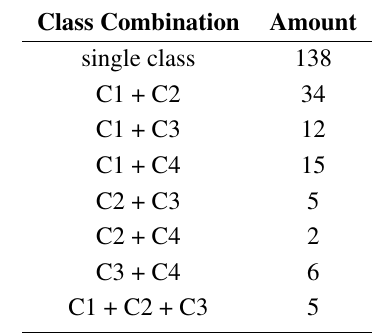
Table 1. Class-change distribution along the calving fronts (C1 = parallel surface structures, C2 = orthogonal surface structures, C3 = IS pattern and C4 = no